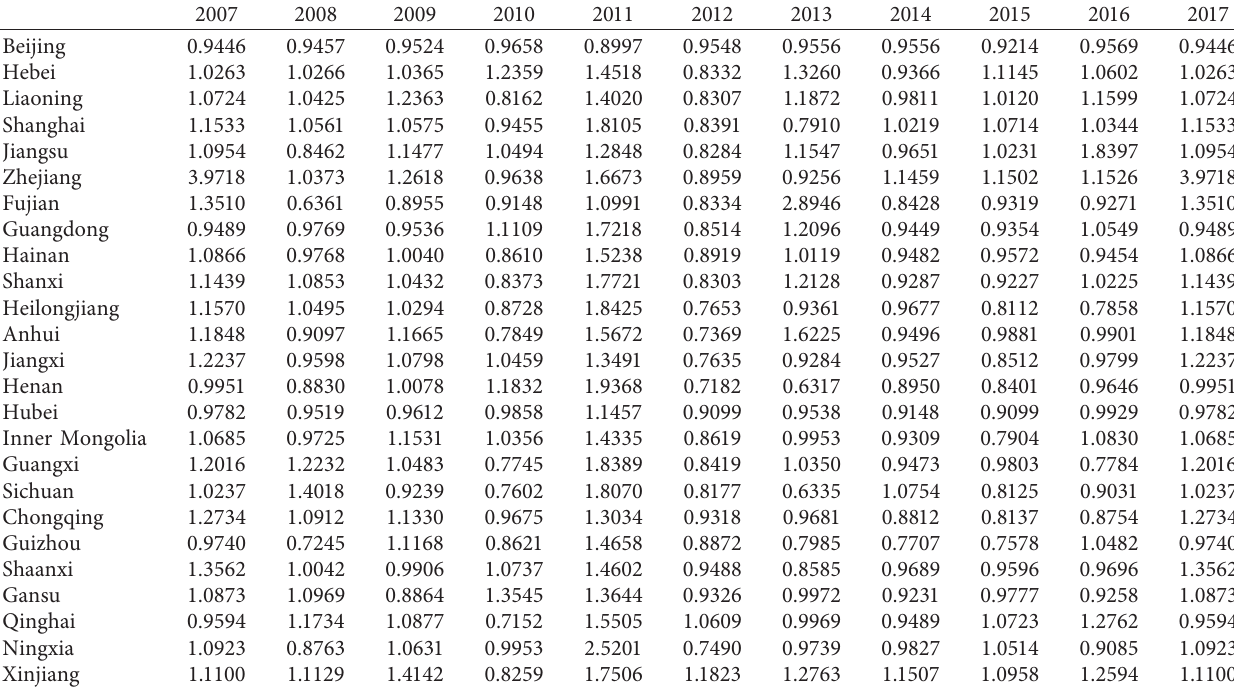
Table 3: Calculation results of the catching-up index of carbon emission reduction technology of 25